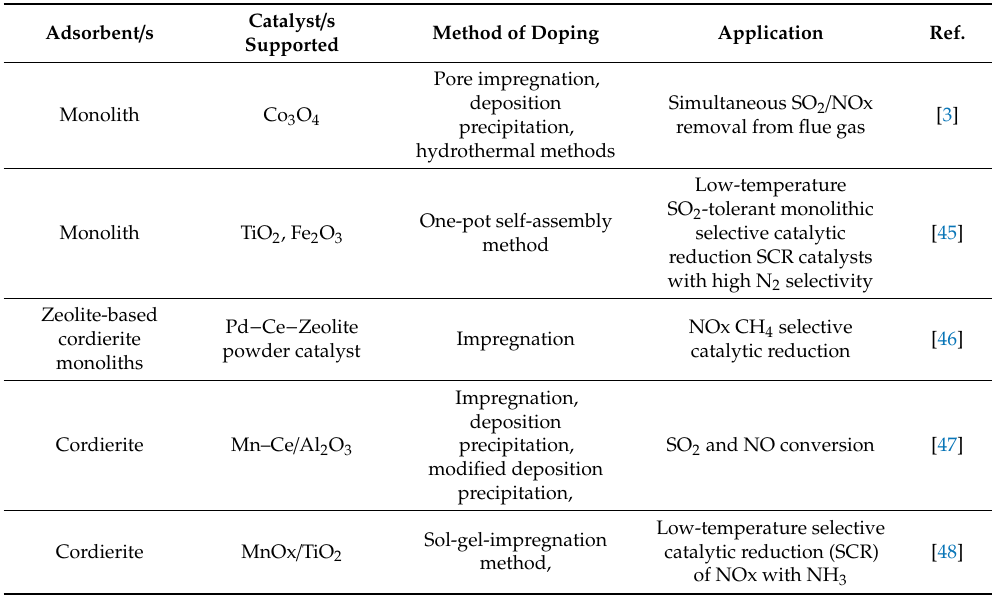
Table 2. The recent application of monoliths as catalysts.